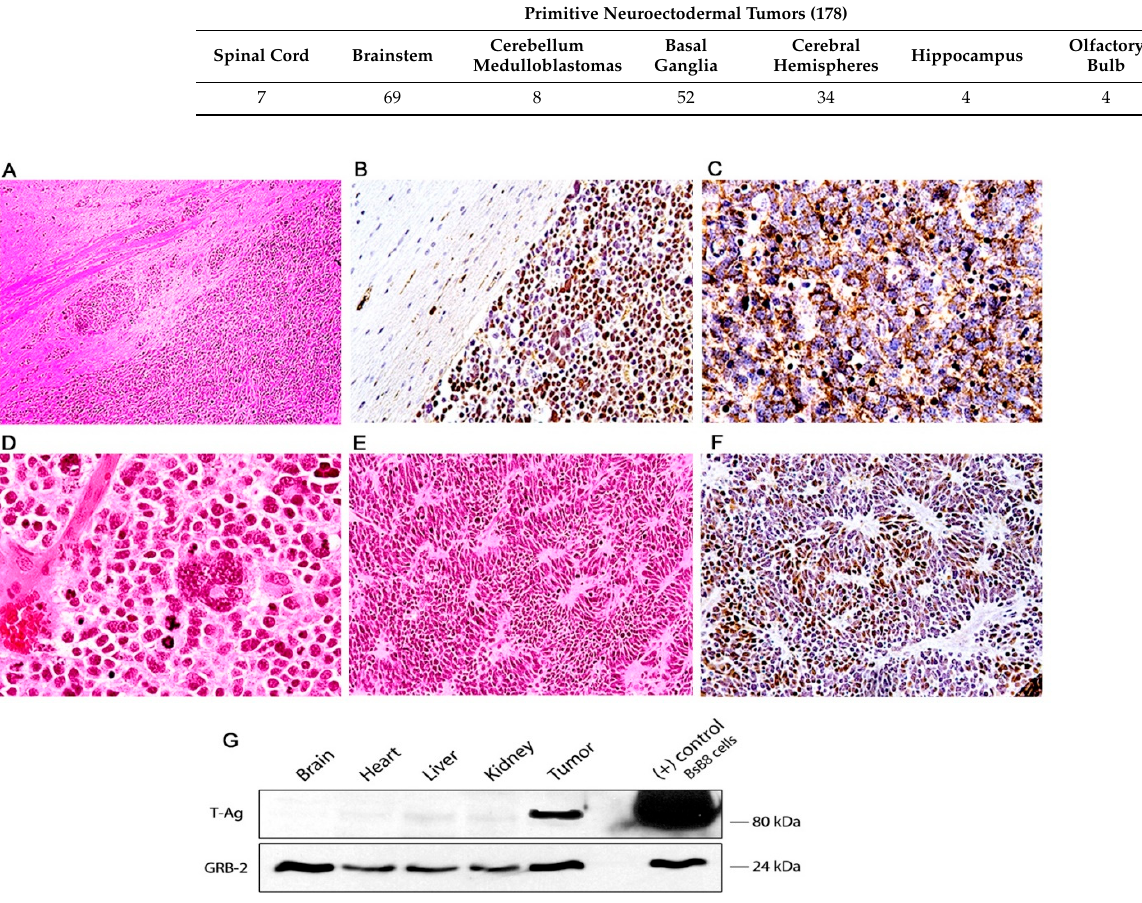
Figure 3. Primitive neuroectodermal tumors in JCV transgenic mice; histological and immunohistochemical characterization. The tumors are composed of sheaths of numerous small and densely packed cells, which diffusely infiltrate the brain parenchyma (Panel ( A ), hematoxylin and eosin, original magnification × 100). Immunohistochemistry for JCPyV T-antigen highlights the presence of the primitive neoplastic cells (Panel ( B ) original magnification × 100). Immunohistochemistry for Class III β -tubulin reveals the early neural origin of the tumors (Panel ( C ), original magnification × 200). At higher magnification the slightly elongated nuclei and scanted cytoplasm of the cells can be appreciated. Numerous mitotic figures and apoptotic bodies are present as well as giant multinucleated cells (Panel ( D ), hematoxylin and eosin, original magnification × 400). The neoplastic cells frequently arrange in a circular, concentric pattern, which resembles Homer-Wright rosette formation. Neoplastic cells in these rosette formations express T-Antigen (Panels ( E ) and ( F ), H&E and T-Antigen respectively, original magnification × 100). ( G ) Western blot from protein extracts of different organs of the transgenic mice, probed with T-Antigen demonstrates the presence of the oncoprotein in the tumor (Medulloblastoma), but its absence in all organs, including the normal brain adjacent to the tumor.